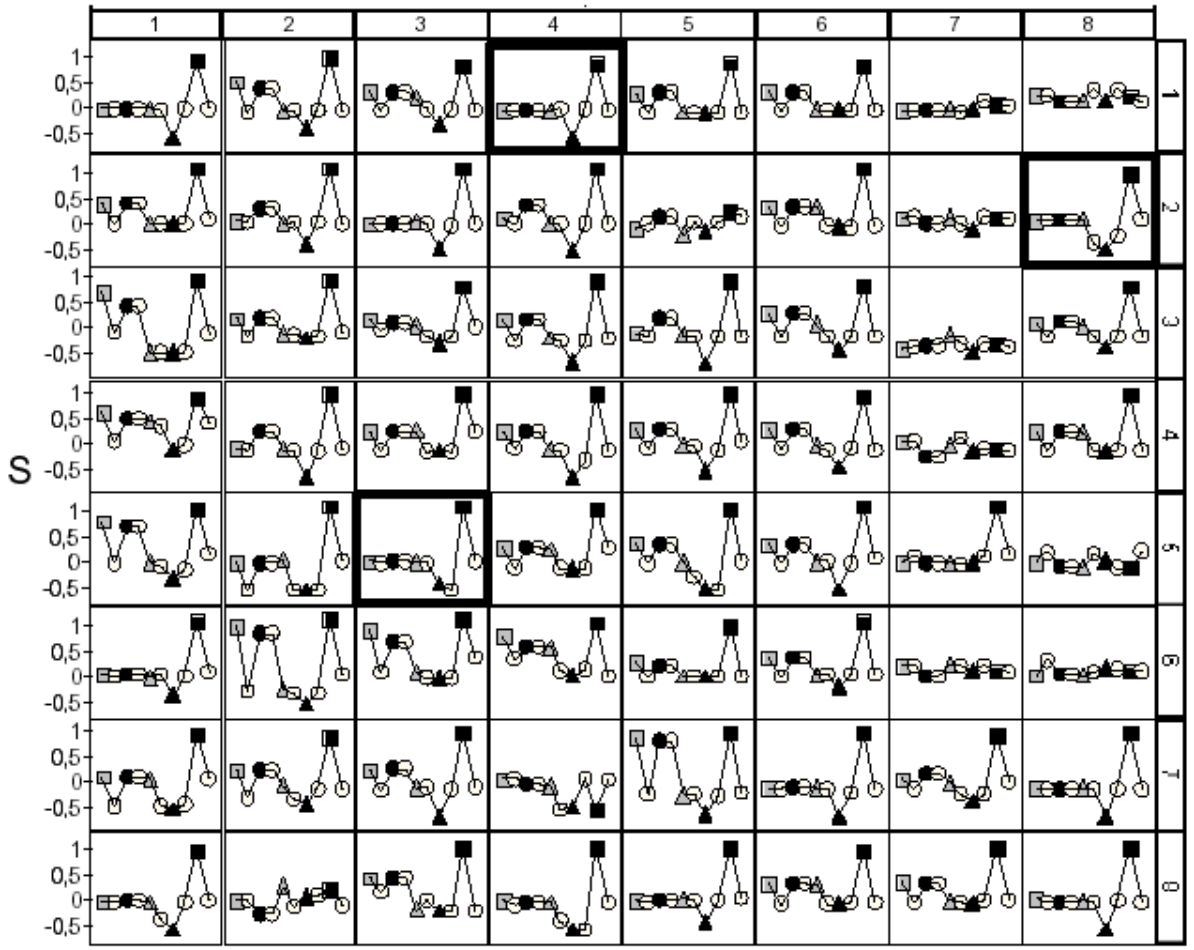
Figure 6. HT-IS screnning results of a Ta 0.2 at% and Y 1 at% bulk doped tungsten oxide library at 300°C. Visualisation of the fingerprints using the software Spotfire ™ . Y-Axis: sensitivities, X-Axis: chronology of test gas impact: